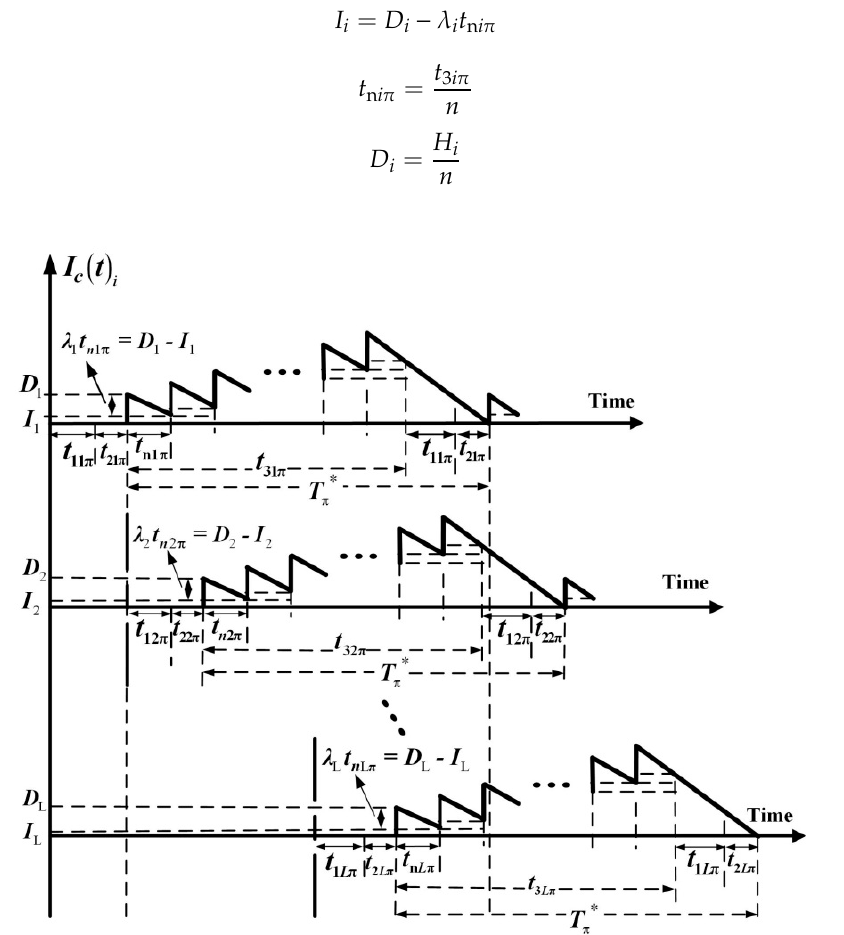
Figure 5. Inventory status at the retailer side.